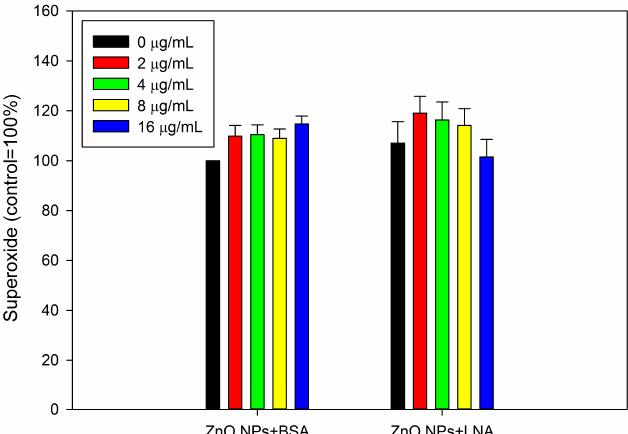
Figure 8. The intracellular superoxide. HepG2 cells were exposed to various concentrations of ZnO NPs (code: XFI06) with the presence of bovine serum albumin (BSA) or α -linolenic acid (LNA complexed to BSA; referred to as LNA) for 3 h, and the intracellular superoxide was measured by using dihydroethidium (DHE).